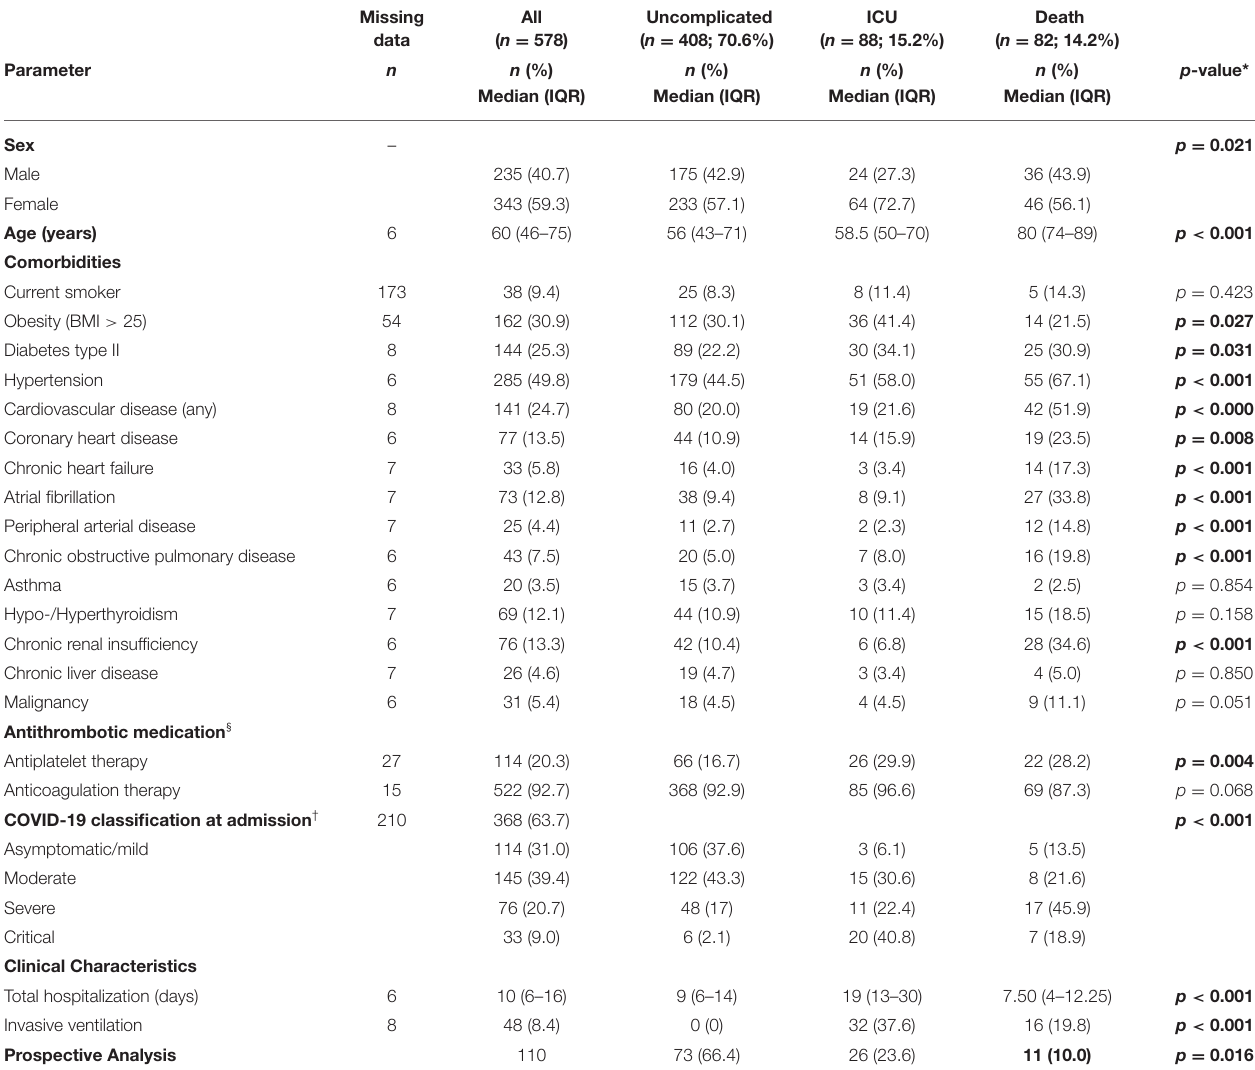
TABLE 2 | Patient demographics (retrospective